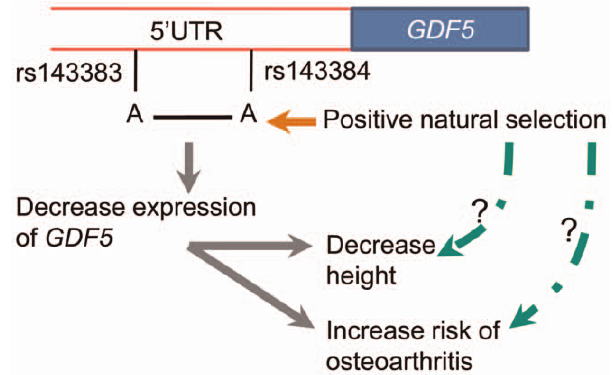
Figure 8. Positive natural selection operated upon the derived alleles of SNPs rs143384 and